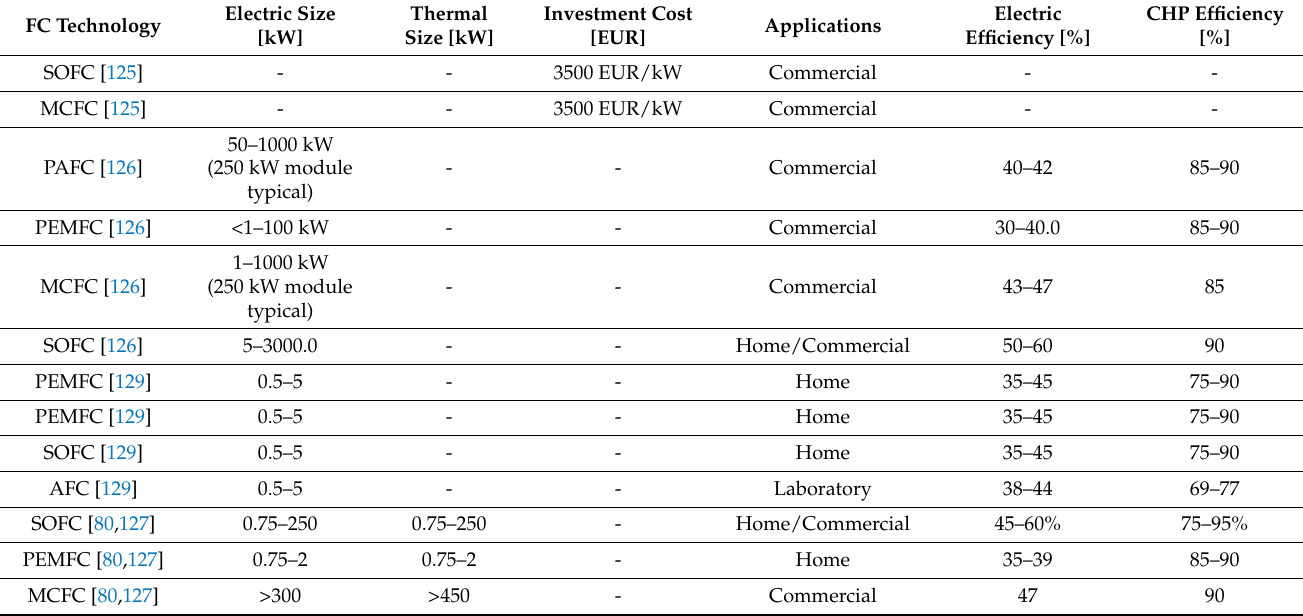
Table 8. Fuel Cell Energy